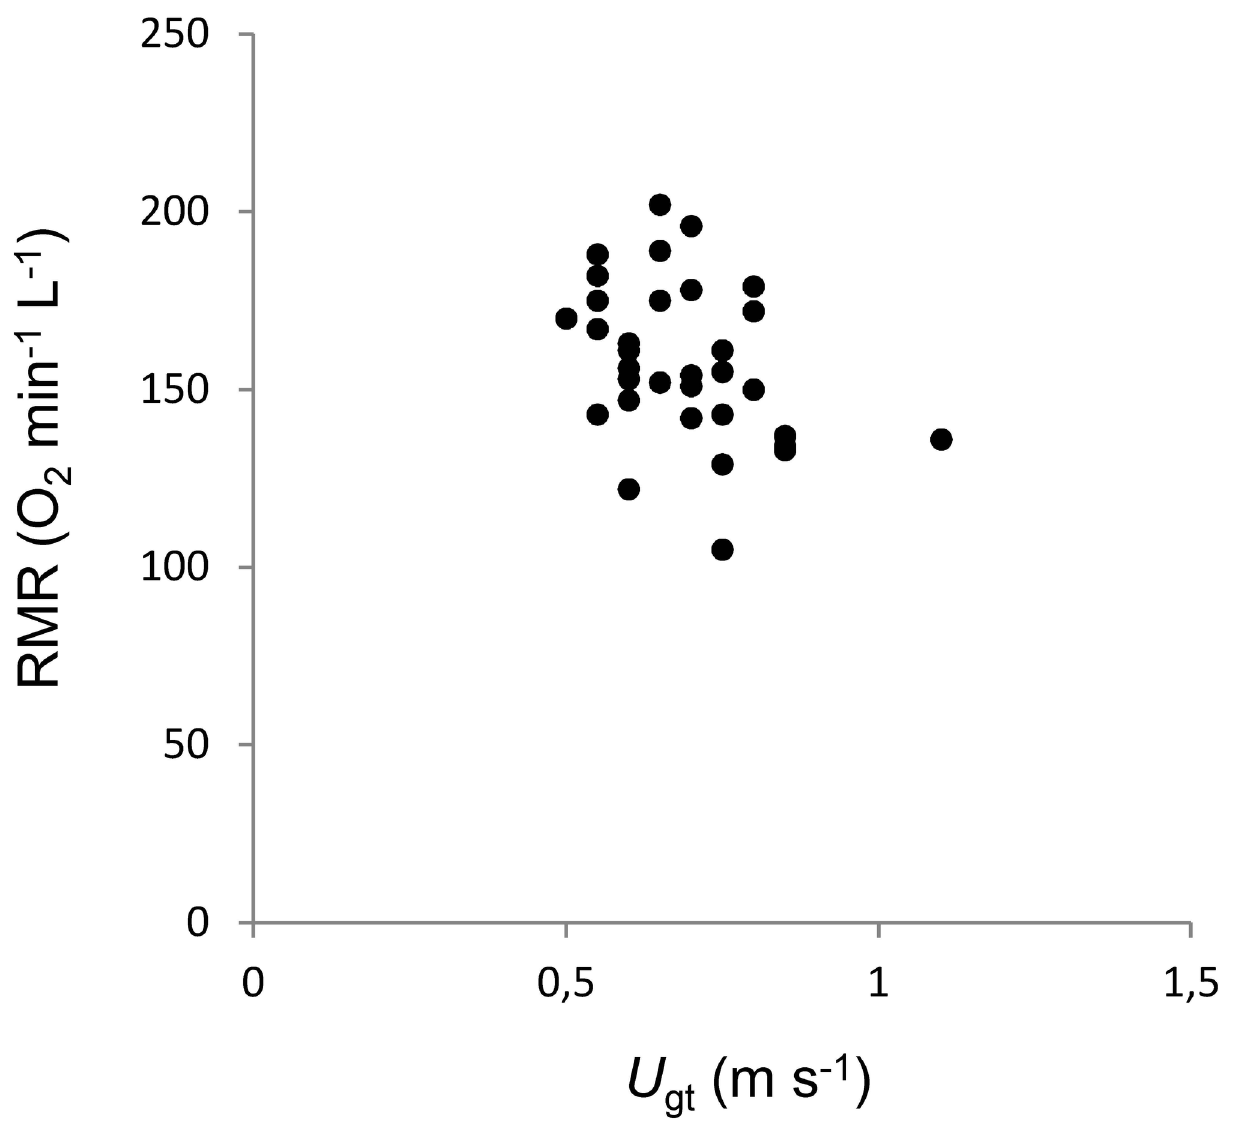
Figure 4. Relationship between (A) U